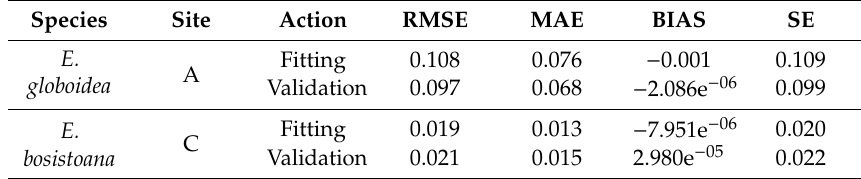
Table 6. Juvenile survival model fitting statistics.